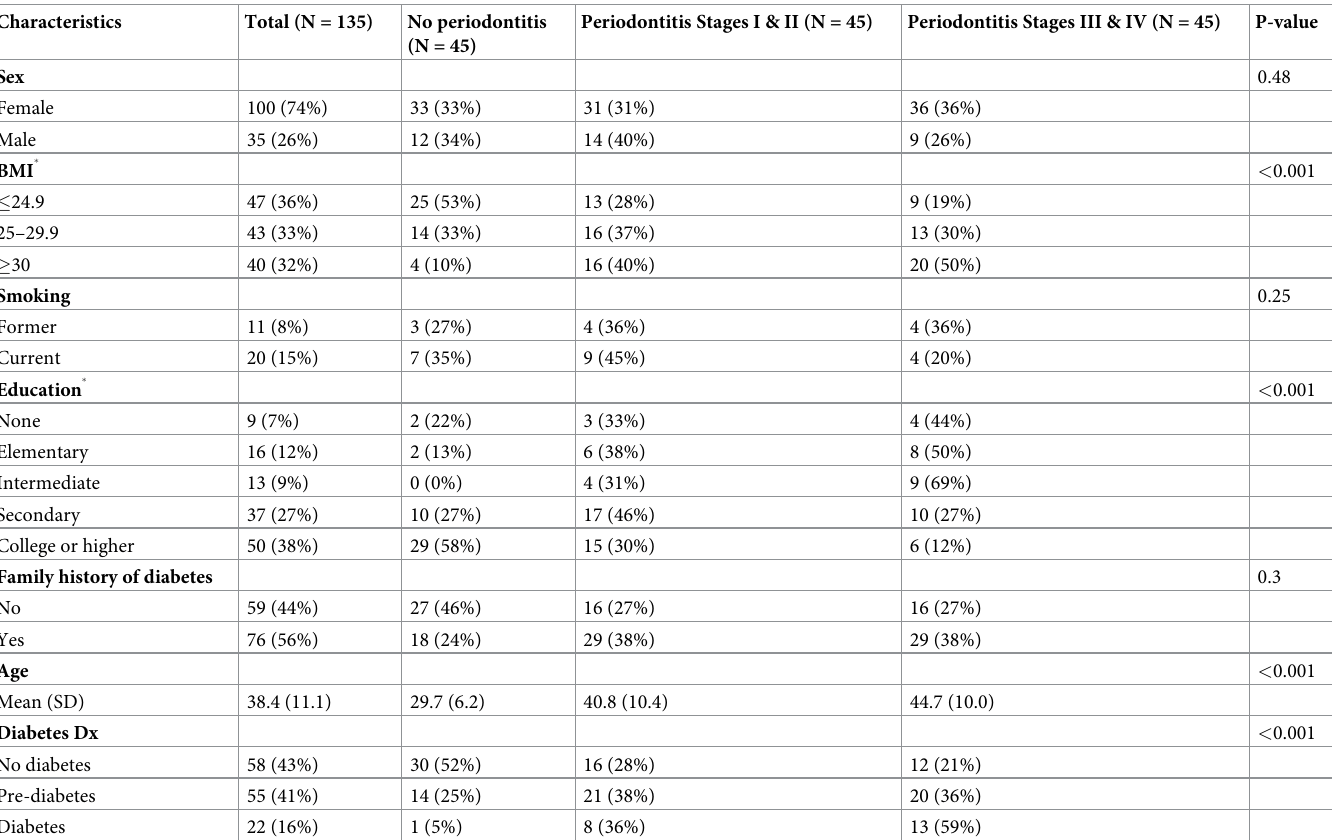
Table 1. Characteristics of the study population by periodontitis